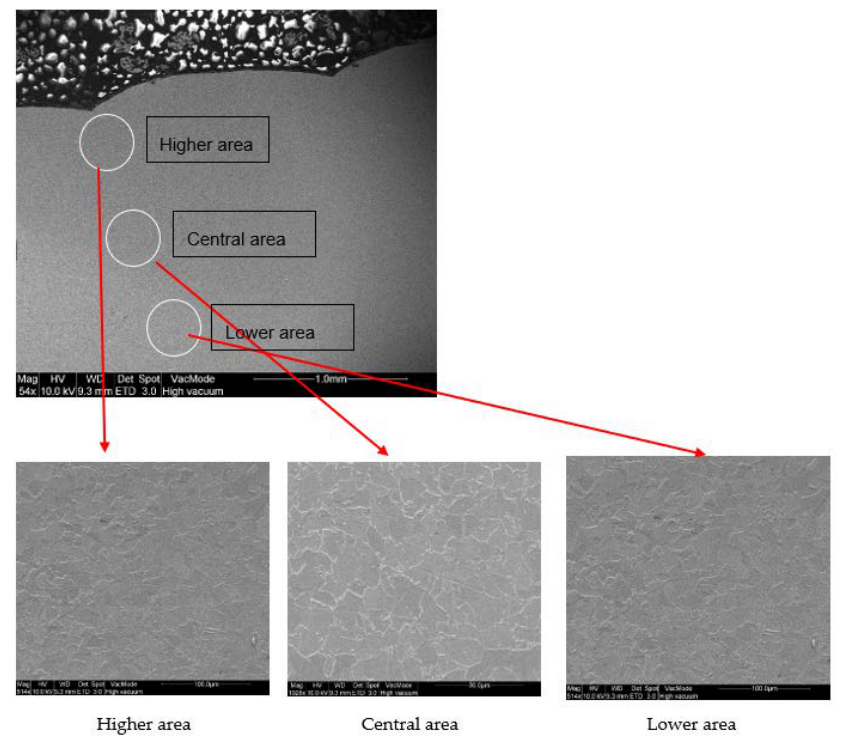
Figure 8. SEM Micrographs at interface between layers in Sample nº 1 (MIG conventional).